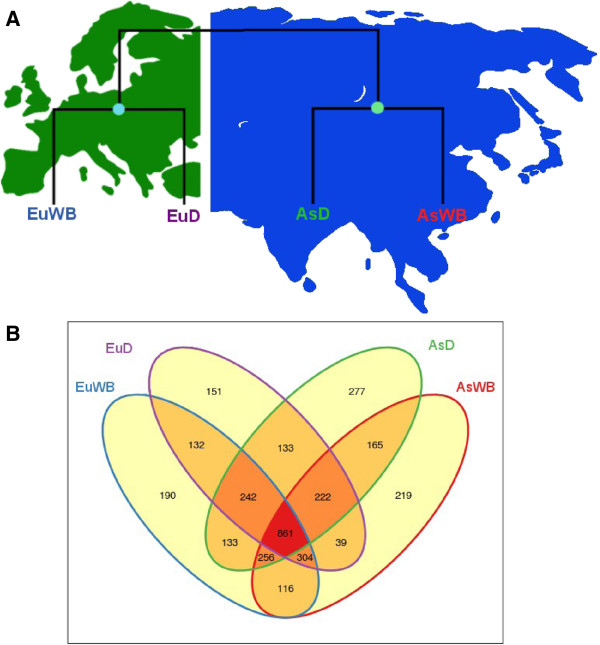
Pairwise comparison between different groups. A) Schematic representation of pigs across Eurasia. Two nodes shows two independent domestication events. B) Shared CNVRs between different populations.